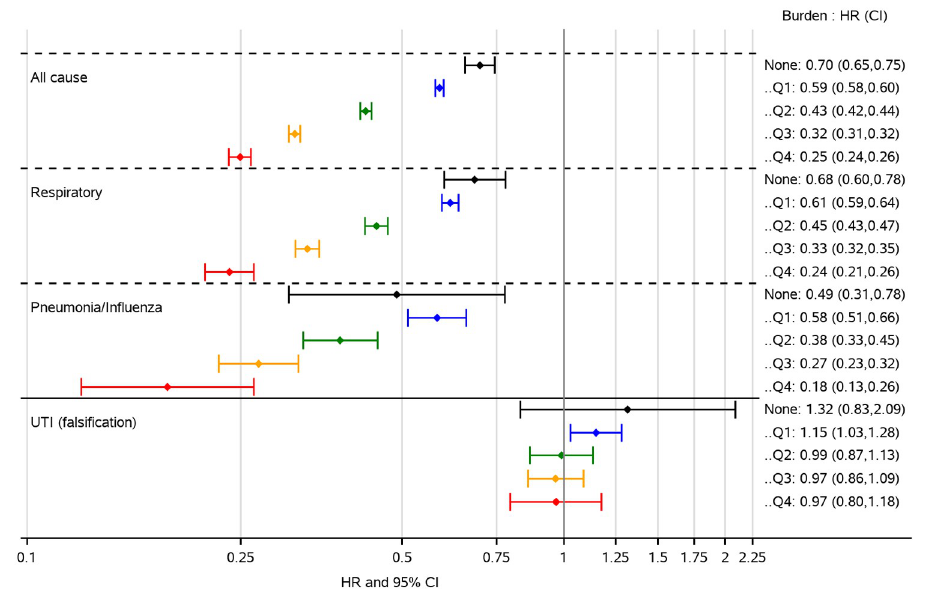
Fig 2. Vaccine effectiveness by cause of death and influenza viral activity level. � UTI—urinary tract infection hospitalization.